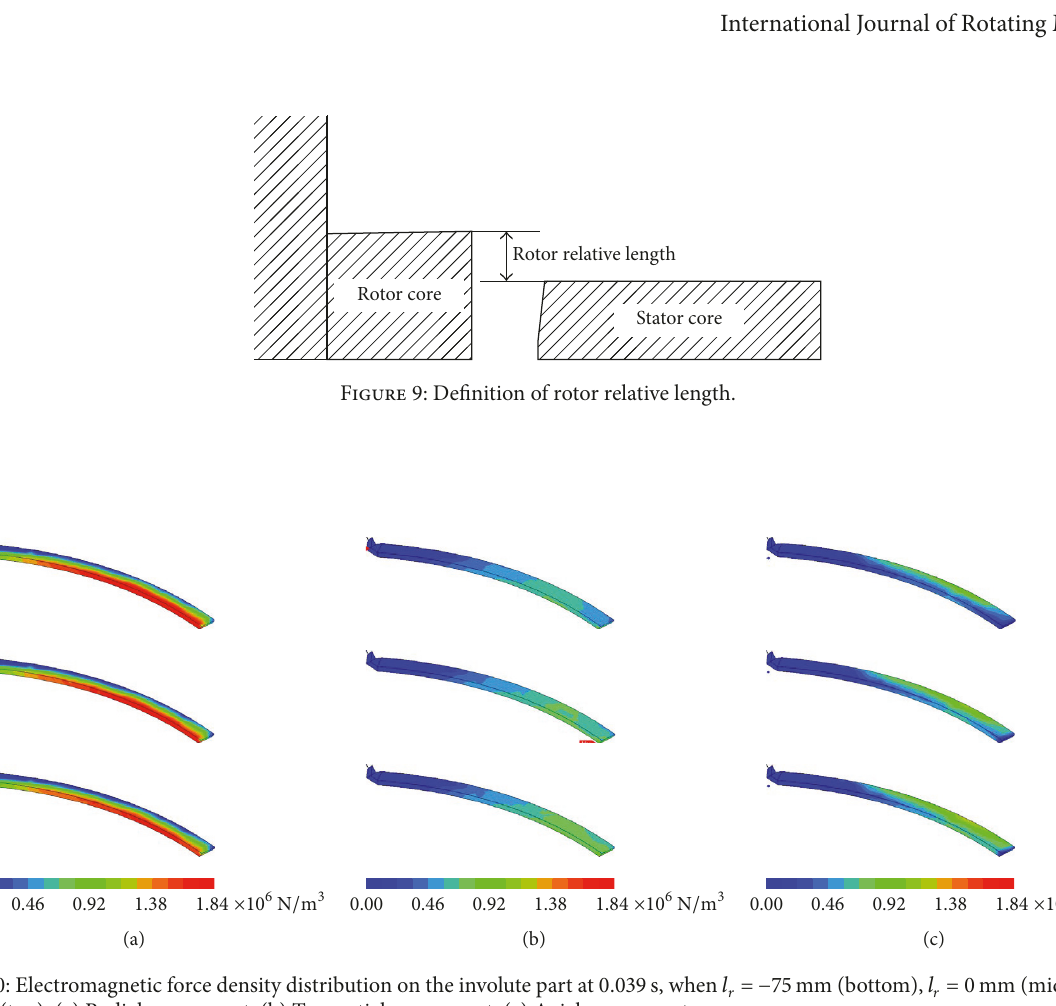
Figure 10: Electromagnetic force density distribution on the involute part at 0.039 s, when 𝑙 𝑟 = − 75 mm (bottom), 𝑙 𝑟 = 0 mm (middle), and 𝑙 𝑟 = 75 mm (top). (a) Radial component. (b) Tangential component. (c) Axial component.